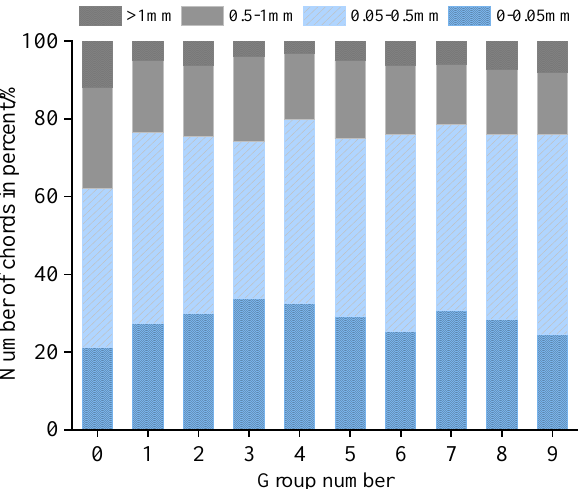
Figure 13. The pore size distribution of the concrete.